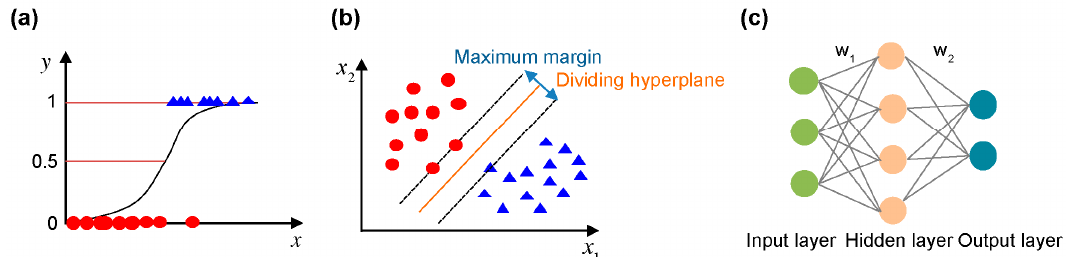
Figure 3. Machine learning (ML) models of ( a ) logistic regression (LR), ( b ) support vector machine (SVM), and ( c ) artificial neural networks (ANN) are described.